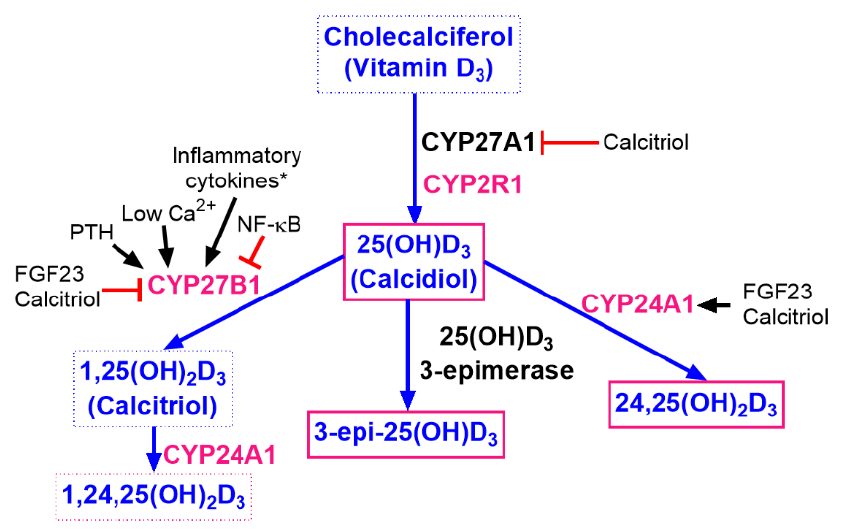
Figure 9. Summary of vitamin D 3 metabolic pathways with selected factors playing an important role in their regulation. CYP27A1 and CYP2R1 are identified as vitamin D 3 -25-hydroxylases converting cholecalciferol to 25(OH)D 3 . CYP27B1: 25-hydroxyvitamin D-1α-hydroxylase converts 25(OH)D 3 to its hormonally active form—1,25(OH) 2 D 3 , calcitriol. CYP24A1: 24-hydroxylase inactivating both 25(OH)D 3 and 1,25(OH2)D 3 . Regulation of CYPs’ expression may differ depending on the tissue studied. * Inflammatory cytokines such as IFNγ, IL-1β, IL-15, IGF-I, EGF, and TGF-β activate CYP27B1 [34]. Pink letters: enzymes measured in our study in the kidney, liver, and tumor tissue. Pink frames: metabolites measured in mice plasma in our study.